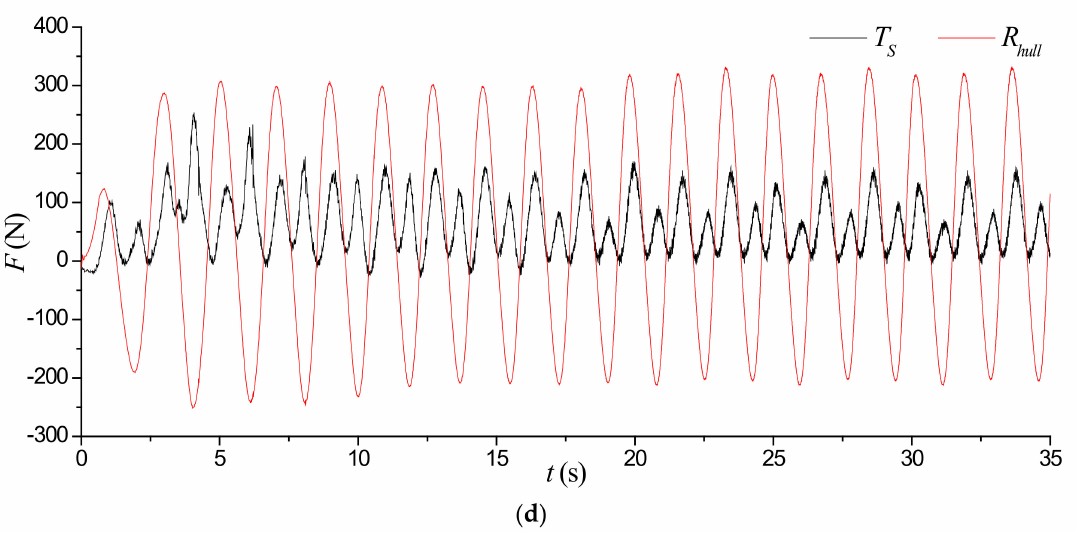
Figure 10. Under different wave parameters and the comparison between T S and R hull . ( a ) The curve of average values of R hull under different wave parameters. ( b ) Variation curves of R hull under different wavelengths when the wave height is 0.25 m. ( c ) Variation curves of R hull under different wave heights when the wavelength is 8 m. ( d ) Variation curves of T S and R hull when the wave height is 0.25 m and wavelength is 8